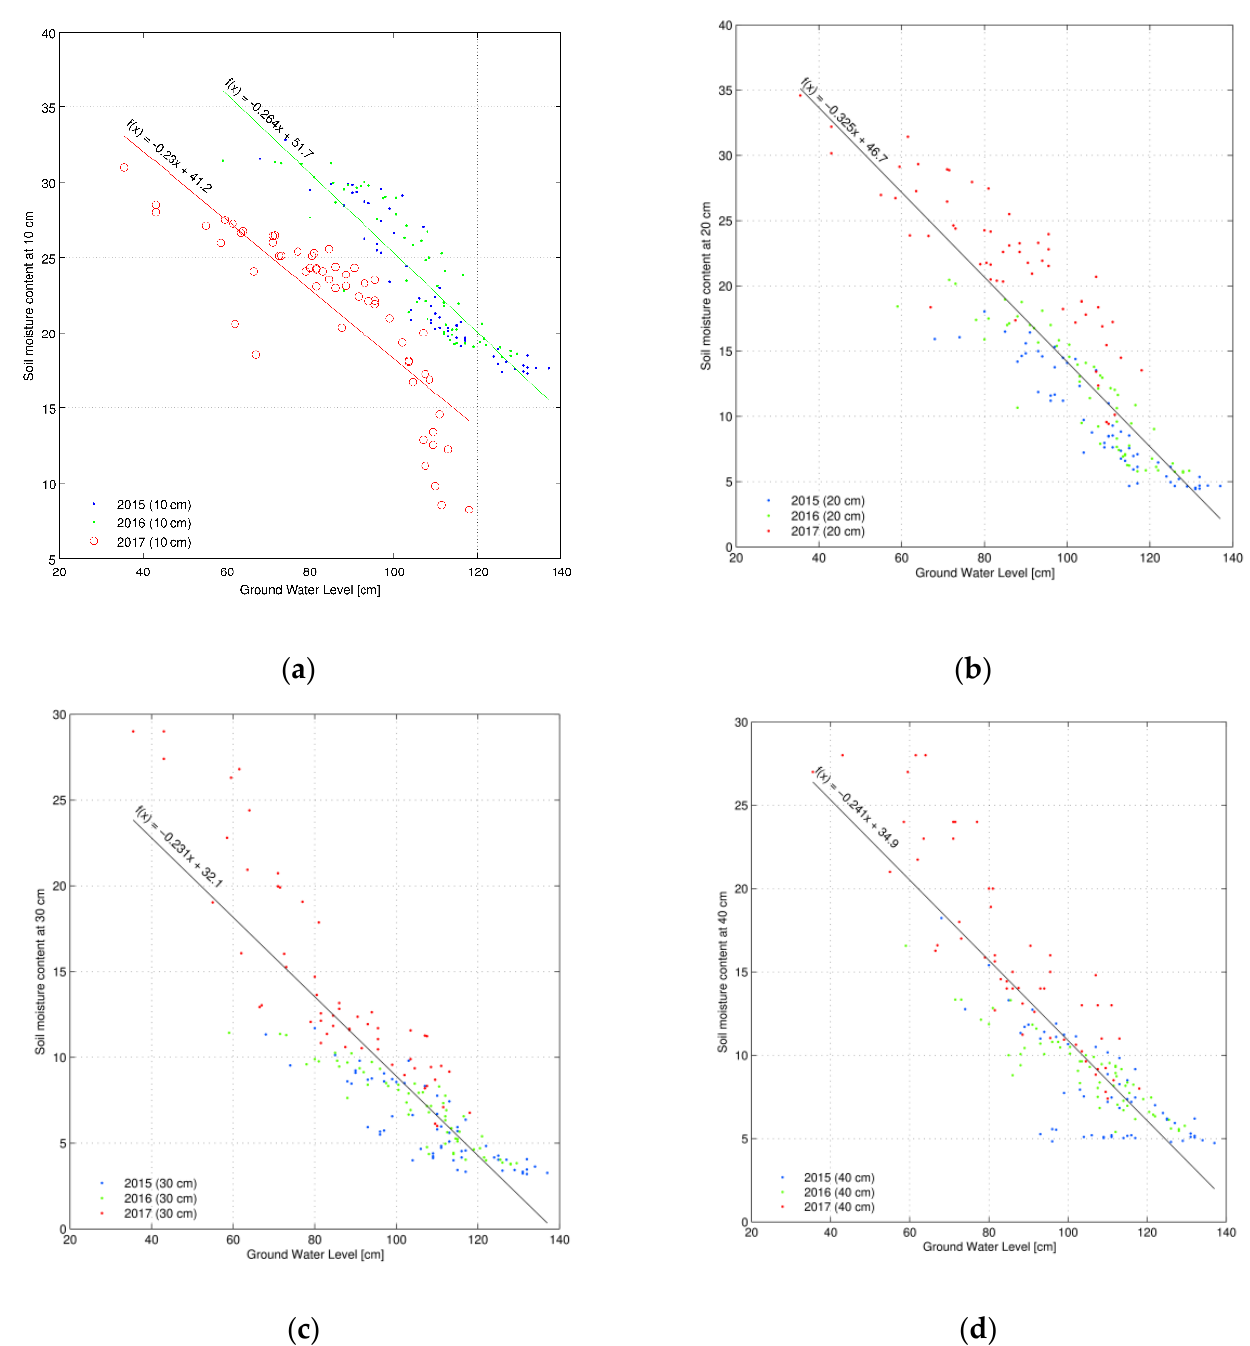
Figure 8. ( a – d ). Regression line relating soil moisture content and ground water level position.